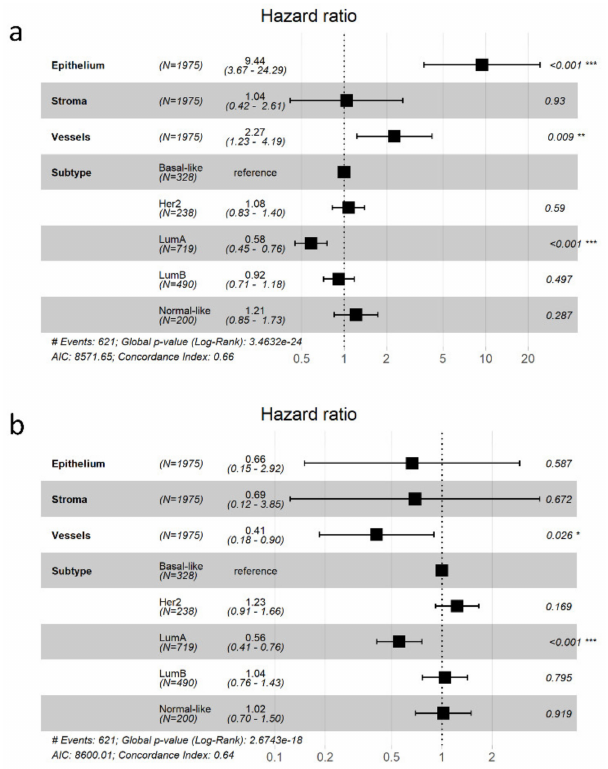
Figure 7. Survival models with epithelial, stromal, and vessel DEGs. Forest plots of multivariate Cox models of disease-free survival with PAM50 subtypes and expression levels of genes in gene signatures ( a ) up- or ( b ) down-regulated in tumor epithelium, stroma, or vessels when compared to corresponding normal tissues (* <0.05, ** <0.01, ***